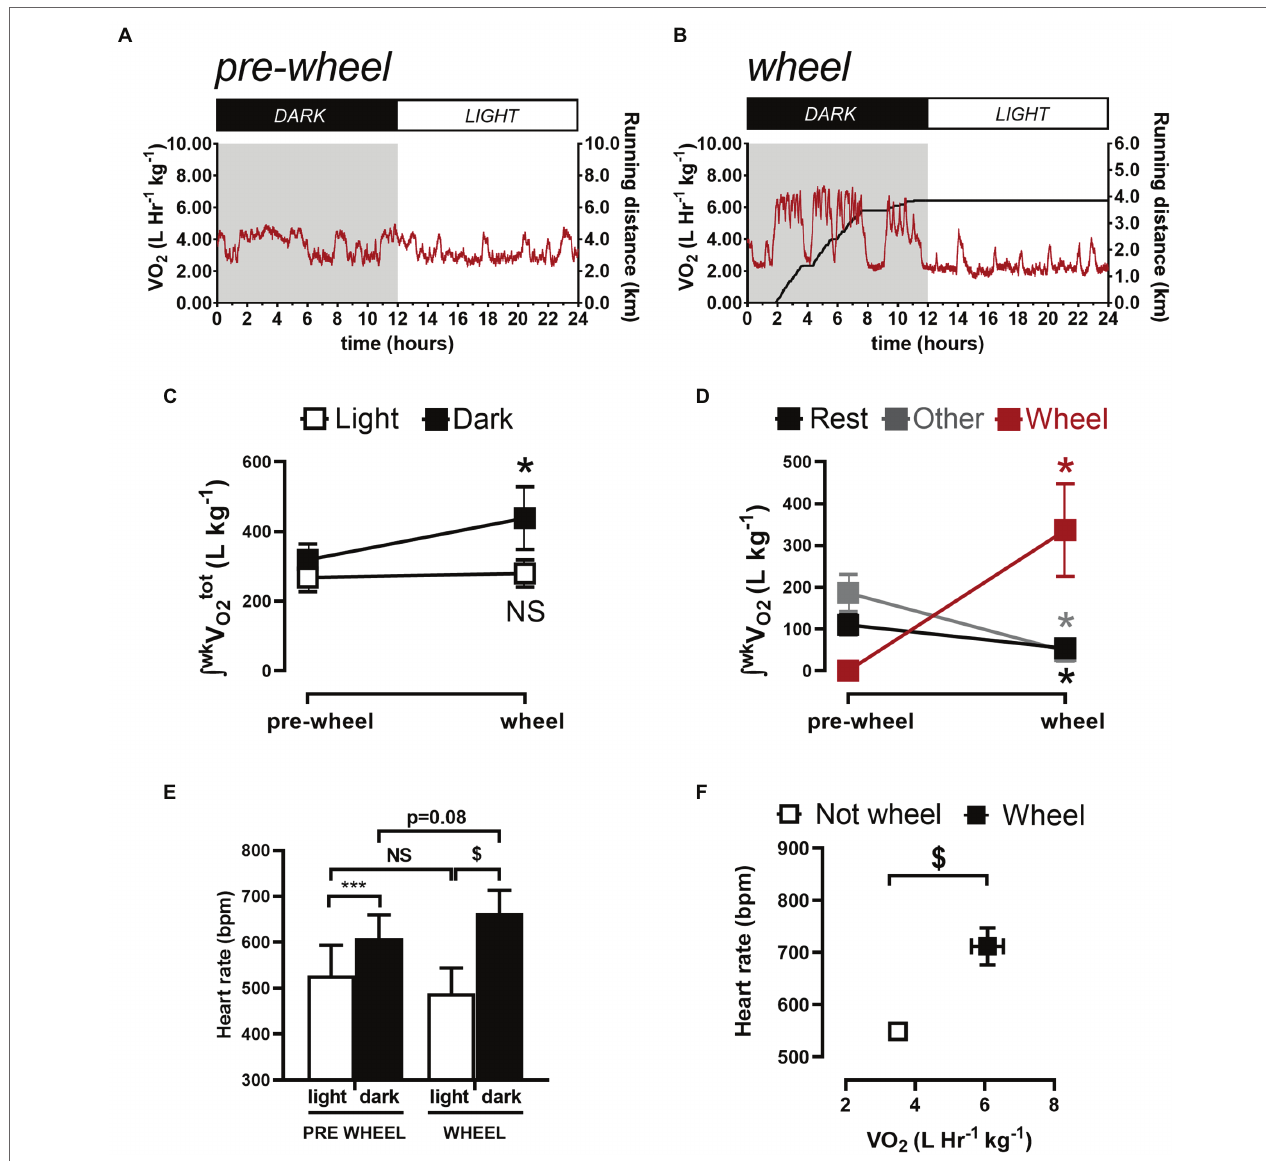
FIGURE 3 | Quantification of weekly total oxygen consumption ( ∫ wk V O2 ) associated with rest, non-rest/non-wheel (other) activity, and running (wheel) activity. Sample 24-h V O2 recordings before (A) and 1 week after (B) a CD1 mouse gained access to a running wheel. (C) shows the integrated O 2 consumed per week by mice during the light (sleeping) phase and during the dark (active) phase, before and after gaining wheel. (D) shows the integrated O 2 consumed per week during the dark phase quantified during rest (sleeping), with wheel running and with “other” activities (i.e., neither sleeping or wheel running). (E) summarizes the HR results during the light and dark phases from before and after gaining access to running wheels. The data reveals that the HR differed between the light and dark phase for mice before and after gaining access to running wheels. HRs in the dark phase increased ( p = 0.02) while trending ( p = 0.08) toward reductions during the light phase after mice gained access to running wheels for 1 week. (F) shows the relationship between HR and the V O2 when mice are not on the wheel versus when they are on the running wheel. Data are presented as Mean ± SD. * p < 0.05, *** p < 0.001, and $ p < 0.0001 using a repeated measures one-way ANOVA with Holm- Š idak post-hoc